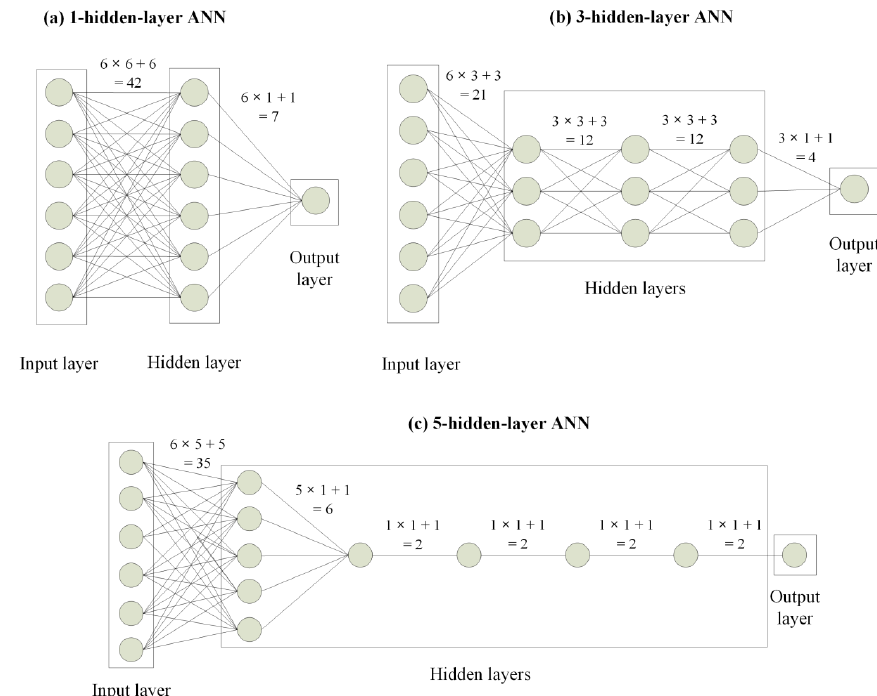
Figure 2. Schematic of the artificial neural network (ANN) with the total parameter number of 49 corresponding to ( a ) 1 hidden layer; ( b ) 3 hidden layers; and ( c ) 5 hidden layers.